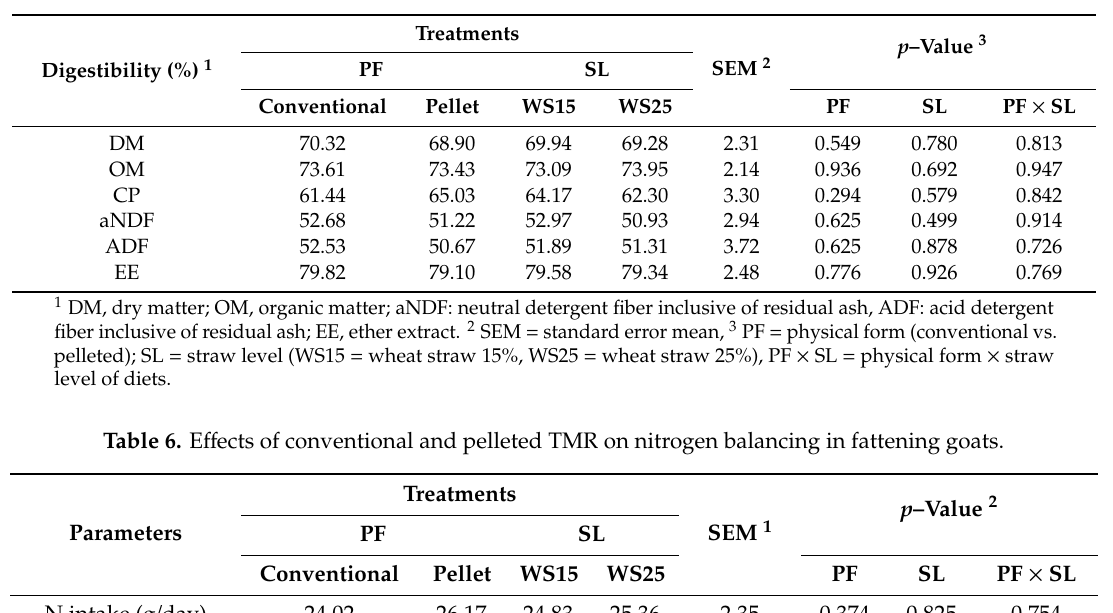
Urinary N (g / day)